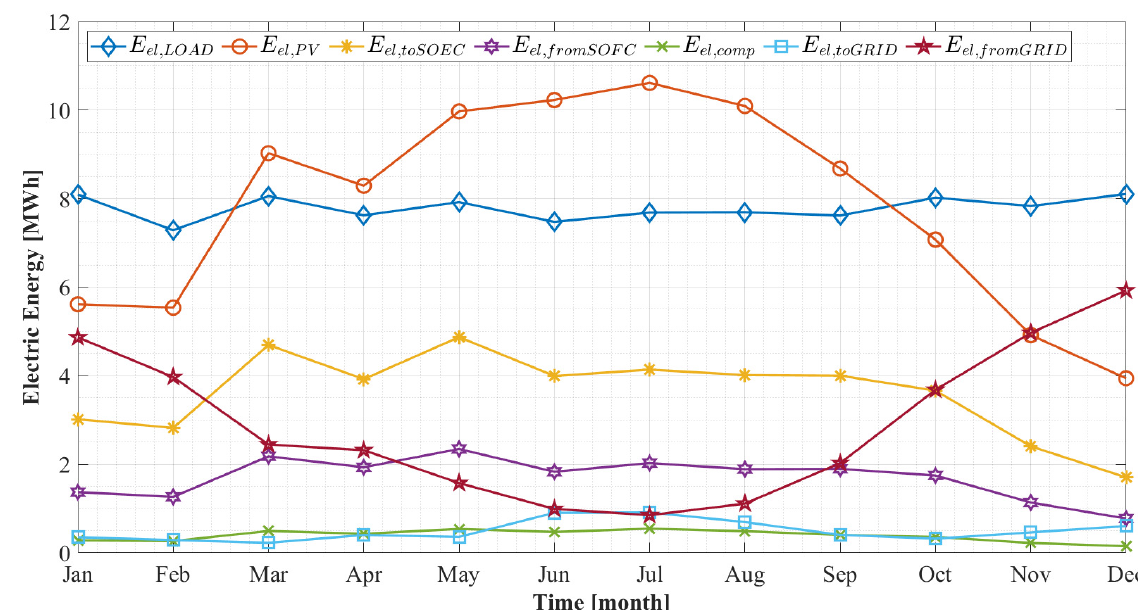
Figure 8. Monthly integration of the results from the dynamic analysis.